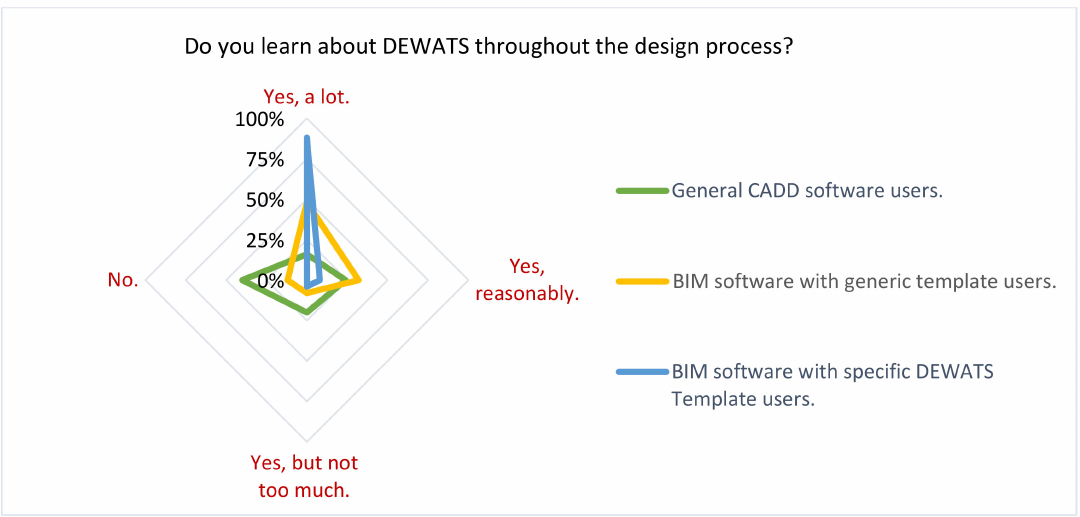
Figure 6. Answers to the fourth question. Source: authors (2020).